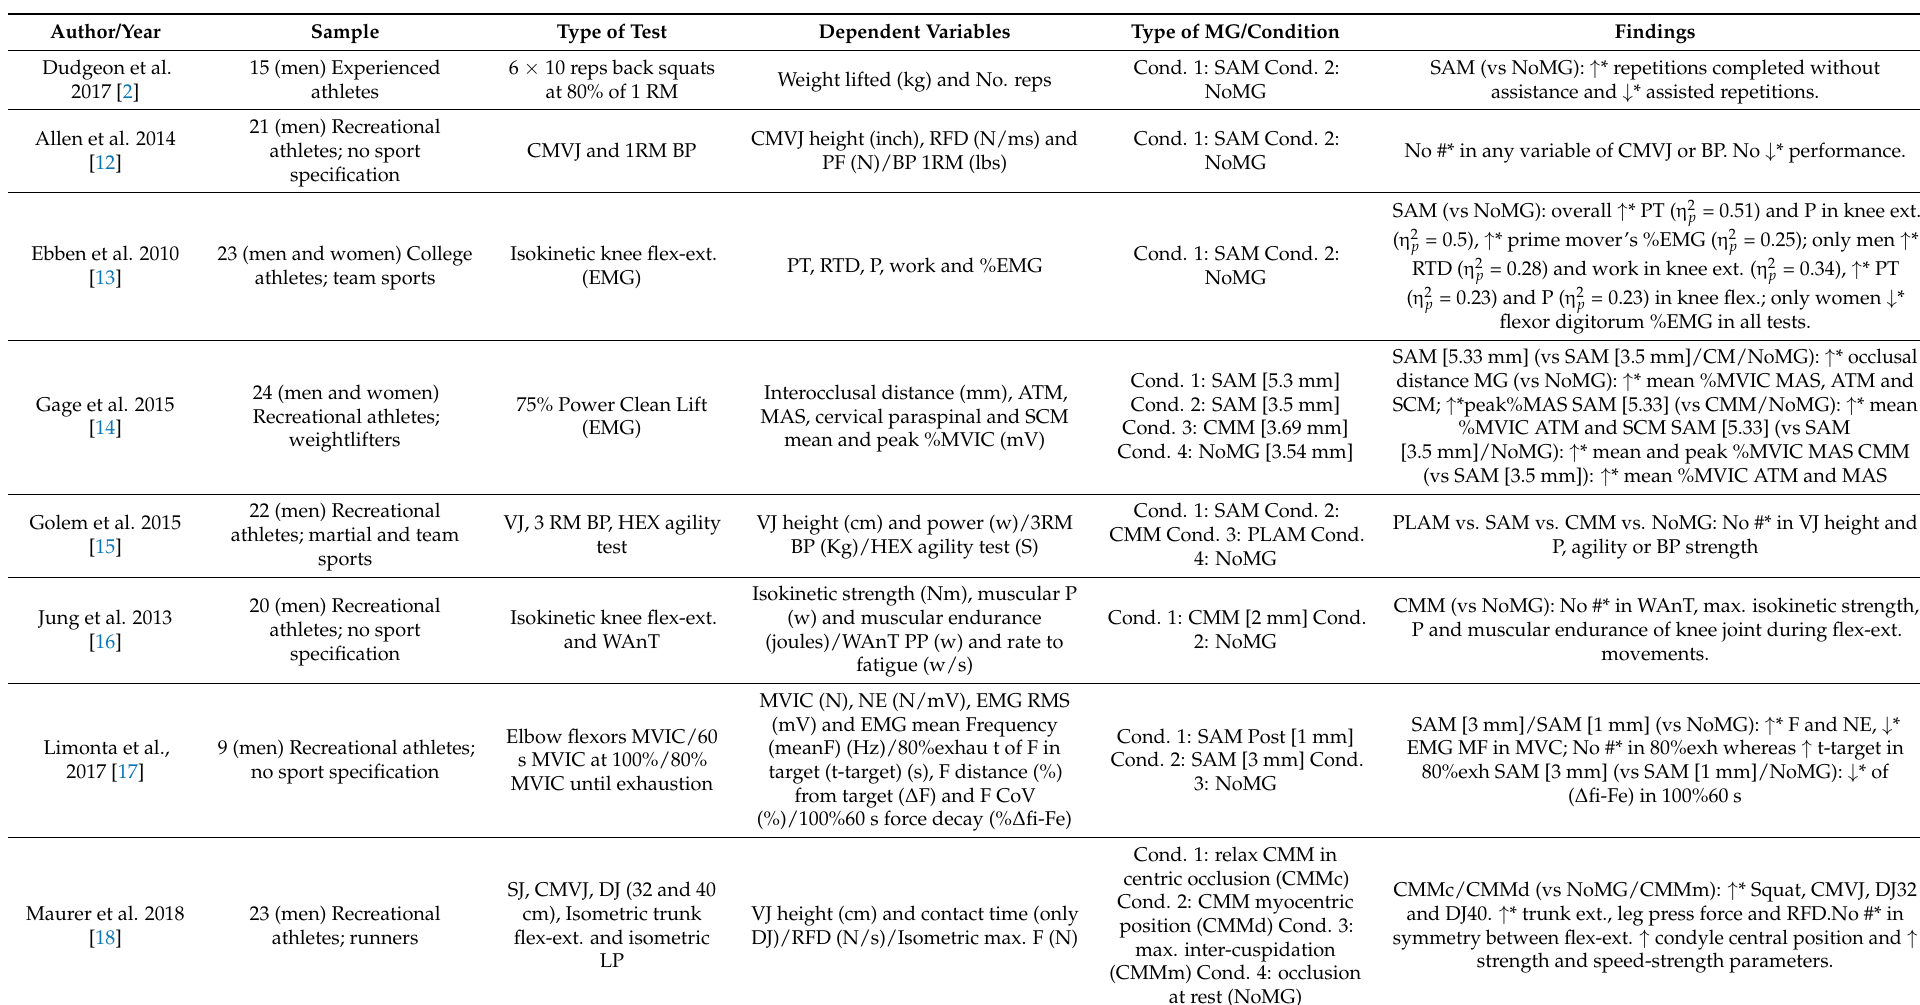
Table 3. Summary of the collected data on acute effects of mouthguards in muscle strength, power, agility and quickness